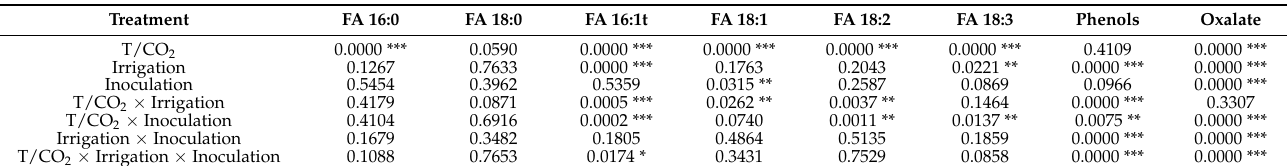
Table 2. Generalized linear model (GLM) significance as p -values for FA and phenol and oxalate content of S. ramosissima shoots under conditions of T/CO 2 , irrigation, and PGPR inoculation (as categorical variables) and their interaction ( p * < 0.05, p ** < 0.01, p *** < 0.001).